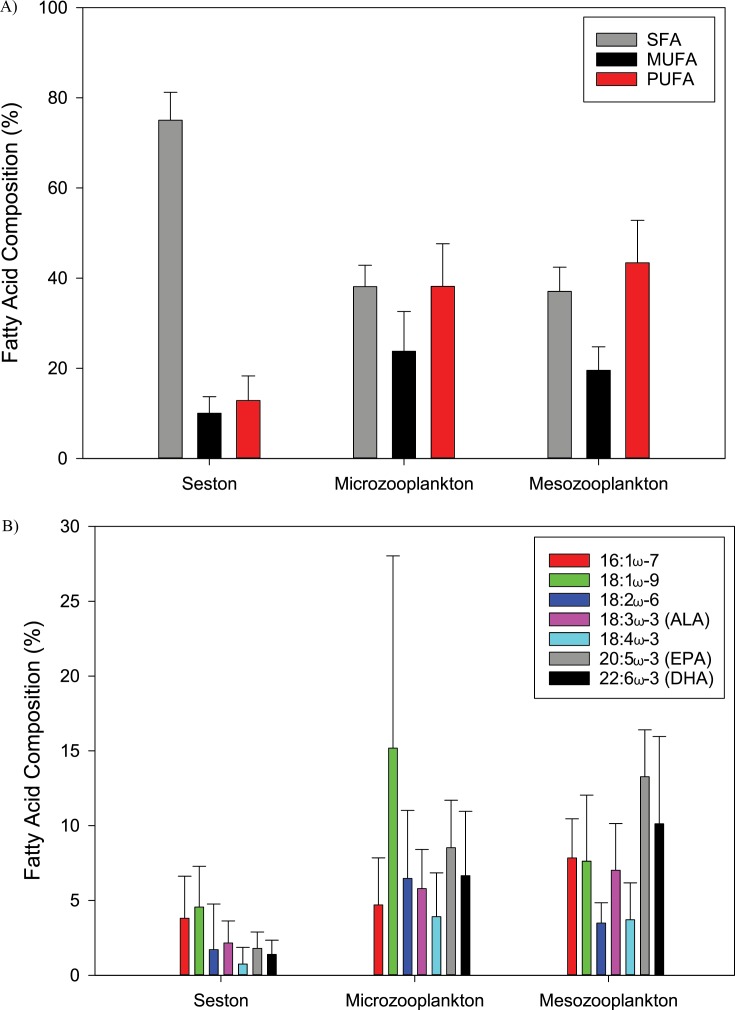
The mean (±S.D.) saturated (SFA), monounsaturated (MUFA), and polyunsaturated (PUFA) fatty acid composition (%) for the seston, microzooplankton, and mesozooplankton (A). The mean fatty acid composition (%, ±S.D.) for the seston, microzooplankton, and mesozooplankton (B).